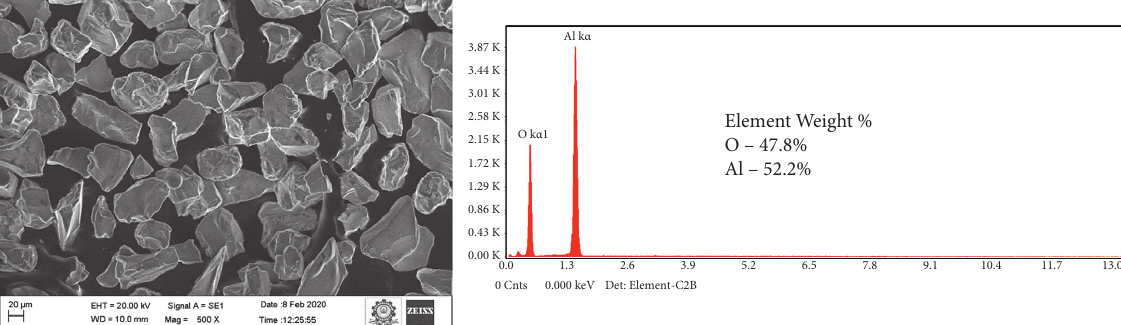
Figure 4: Electron image of the erodent particle with spectroscopic results.